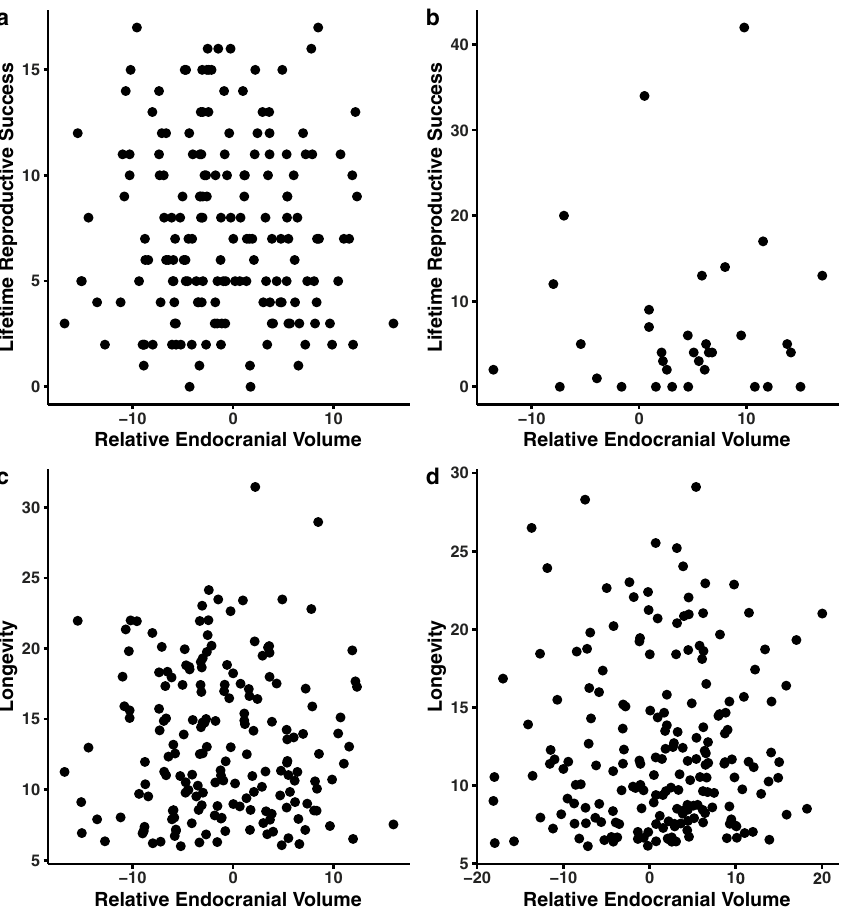
Figure 3. Relative endocranial volume against: ( a ) lifetime reproductive success (females) (n = 177); ( b ), lifetime reproductive success (males) (n = 34); ( c ) longevity (females) (n = 186); ( d ), longevity (males) (n = 198). The x-axis depicts the residuals of a linear model (i.e., endocranial volume ~ geometric mean). Lifetime reproductive success is the number of offspring to survive to one year. Longevity is measured as age at